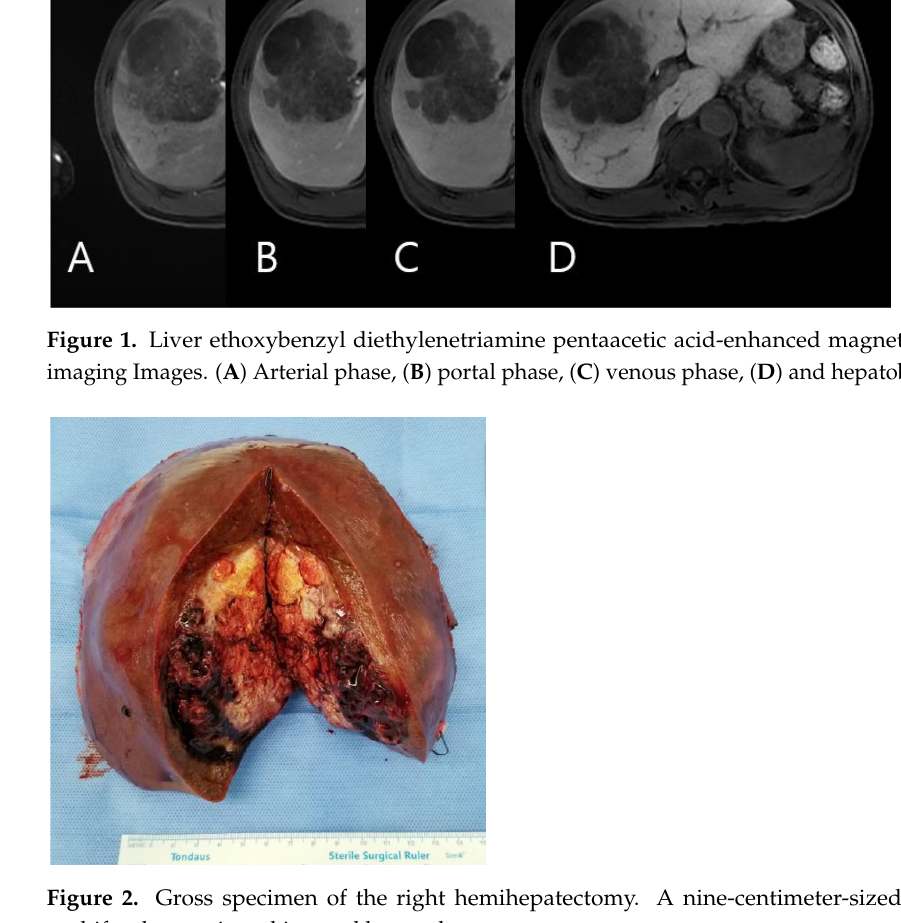
Figure 3. Microscopic findings. Hematoxylin and eosin stain demonstrated the intermingled HCC (top) and the large- and small-cell NEC (bottom) of the image ( A , magnification ×200). The NEC stains positive for chromogranin ( B , magnification ×100) and synaptophysin ( C , magnification ×100). 3. Discussion Primary hepatic NEC is very rare, with an incidence of 0.46% among primary hepatic malignancies [1]. On the other hand, HCC is the most common hepatic malignancy. Some- times, HCC is often combined with other malignancies. Combined HCC and cholangio- carcinoma is the most common type, accounting for 2.0 – 3.6% of primary hepatic malig- nancies [2]. Mixed HCC-NEC is extremely rare. Including our case, only 30 cases have been reported to date. Two hypotheses have been proposed for the origin of primary hepatic NEC [3]. First, neuroendocrine cells in the intrahepatic bile duct epithelium undergo malignant transfor- mation and become NEC cells. Second, NEC originates from hepatic stem cells that have dedifferentiated from other malignant hepatic cells and converted into neuroendocrine cells. In our case, the NEC cells were positive for immunostaining of AFP and hepatocyte antigen, which could support the latter hypothesis.